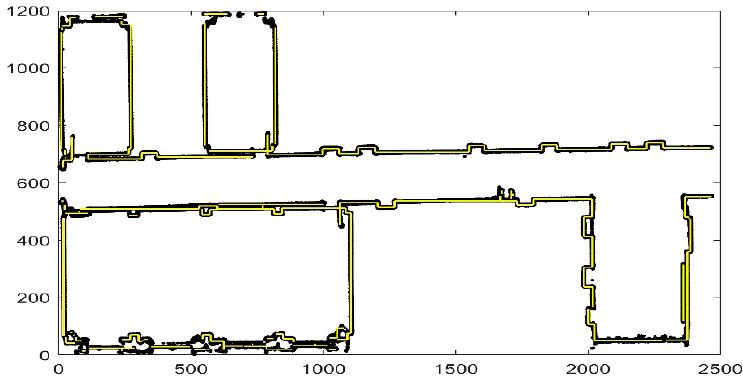
Figure 19. Comparison of experimental results. The yellow line is the result that we obtain and the black points are the raw data. We obtain the basic outline of the data, and the reason why some parts are not considered lines is that the points are discontinuous or the slope changes are complicated.